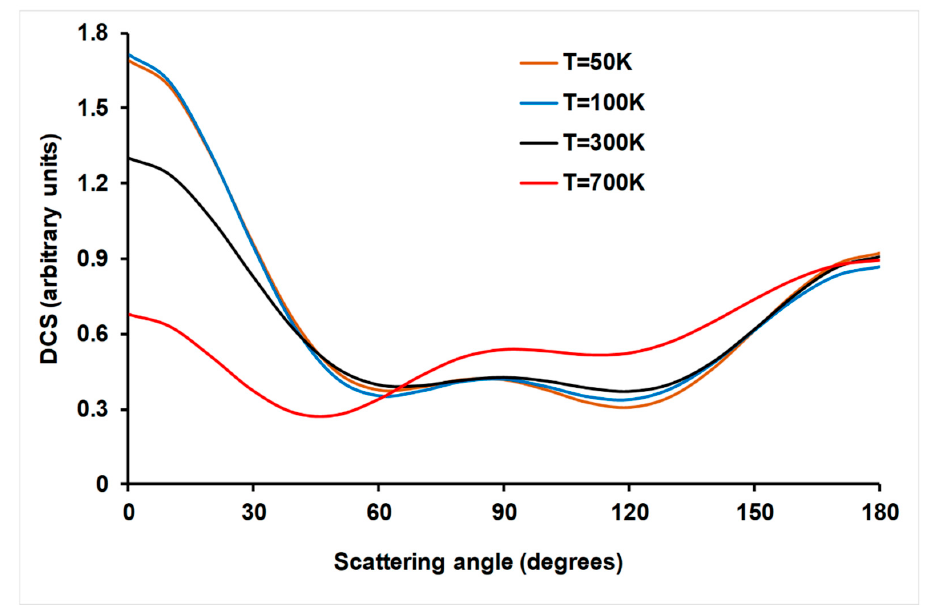
Figure 6. QCT/PES-2020 product angular distributions at different temperatures for HCN product (with respect to the incident CN).